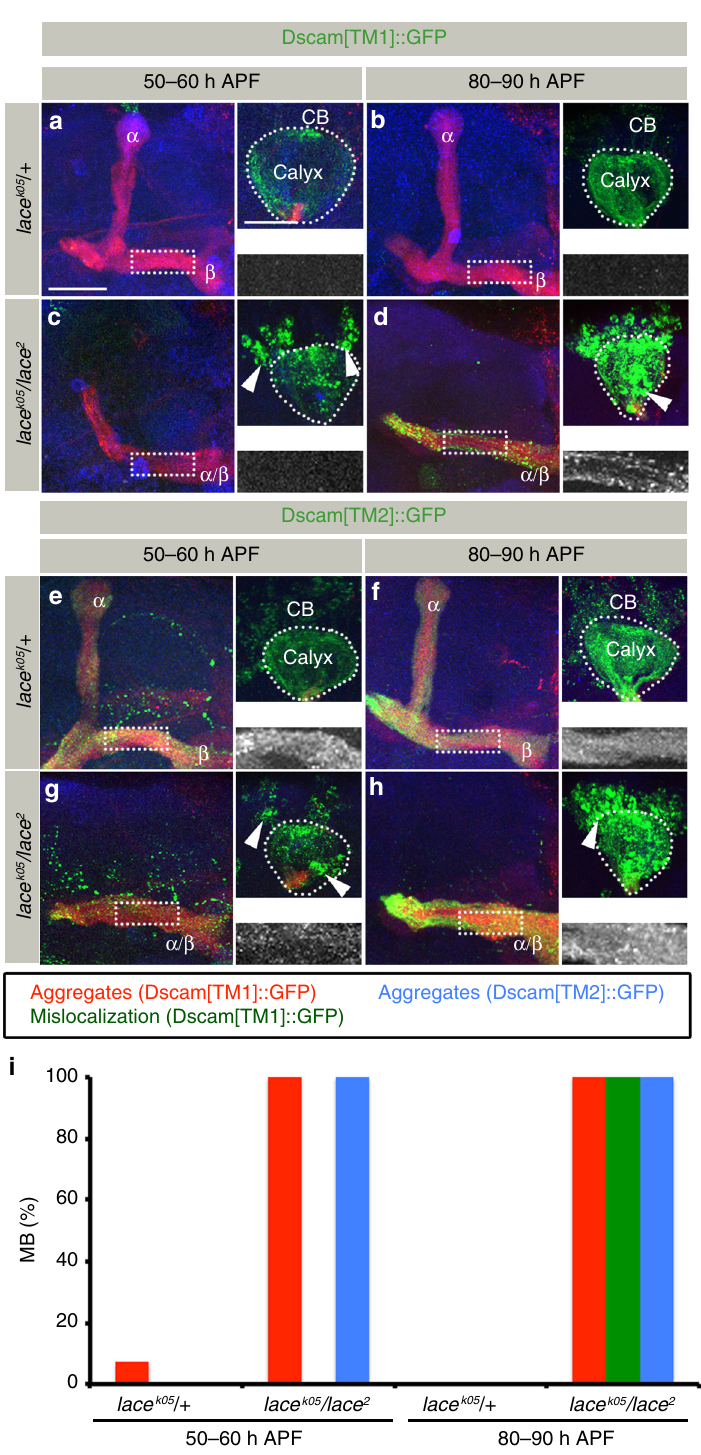
Fig. 8 Dscam aggregates show intra-cellular translocation in SPT mutants. a – d Distribution of Dscam[TM1]::GFP in lace k05 / + ( a , b ) and lace 2 /lace k05 ( c , d ) at two pupal developmental stages: 50 – 60 h APF ( a , c ) and 80 – 90 h APF ( b , d ) expressed using α / β neuron-speci fi c Gal4 ( R65G04-Gal4 ). While images a – d represent the axonal half of the MB, the corresponding somato-dendritic area is represented in right upper insets. The white dotted rectangle represents Dscam[TM1]::GFP distribution in the axons, zoomed in and shown in the right lower inset. Dscam[TM1]::GFP shows an early formation of aggregates (( c ), arrowheads) followed by axonal mislocalization ( d ) in lace mutants. n ( a ) = 14, n ( b ) = 14, n ( c ) = 14, n ( d ) = 12. e – h Distribution of Dscam [TM2]::GFP in lace k05 / + ( e , f ) and lace 2 /lace k05 ( g , h ) at two pupal developmental stages: 50 – 60 h APF ( e , g ) and 80 – 90 h APF ( f , h ) expressed using α / β neuron-speci fi c Gal4 (R65G04-Gal4). Dscam[TM2]::GFP shows reduced axonal localization early in development with formation of somato-dendritic aggregates (Compare ( e ) and ( g ), arrowheads) in SPT mutants. This is followed by a non-homogeneous distribution in the axons ( h ). n ( e ) = 18, n ( f ) = 8, n ( g ) = 8, n ( h ) = 20. i Percentage of MB showing somatic aggregates and axonal mislocalization of Dscam[TM1]::GFP and Dscam[TM2]::GFP in MB at different developmental times. a – h Green: GFP, Red: FasII, Blue: N-Cad. Arrowheads indicate somatic aggregates of Dscam. Scale Bar: 25 μ